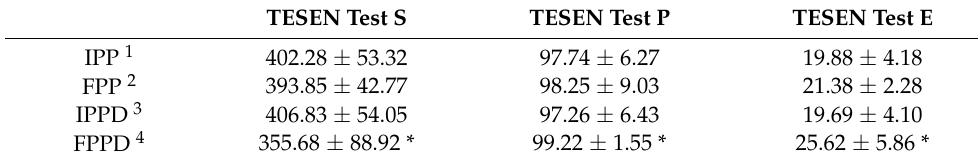
Table 3. Evolution of results obtained over time in TESEN test with product and placebo.